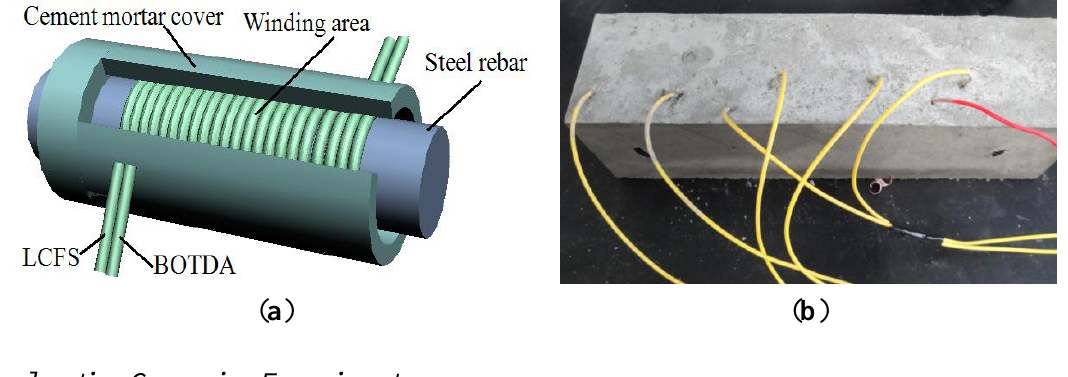
Figure 4. The schematic of the sensing fibers inside the RC and the experimental specimen.